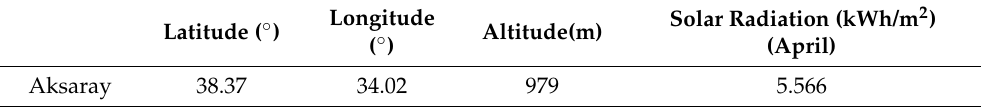
Table 2. Geographical and solar parameters for Aksaray.